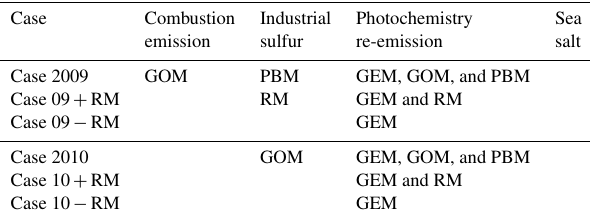
Table 10. Impact of combining or excluding GOM and PBM on PMF factor contributions (>15%) to Hg